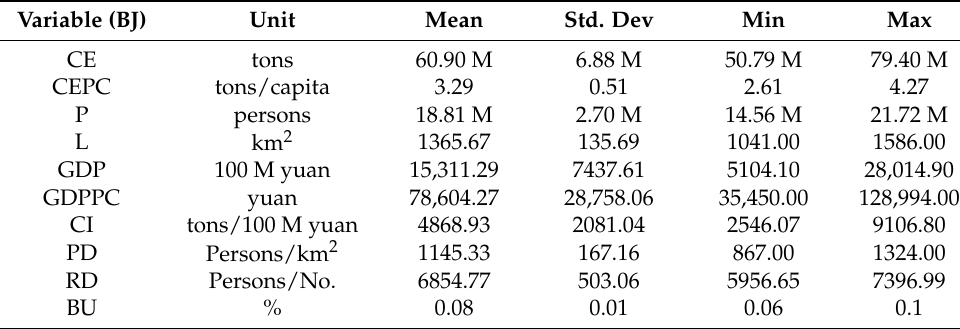
Table 2. Descriptive statistics of variables in Beijing.